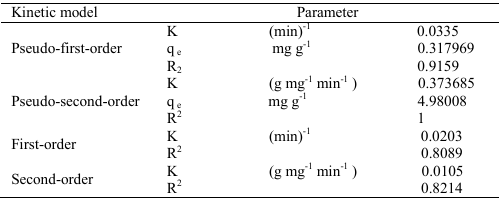
Table 1:Kinetic parameters for Hg(II) sorption onto nanocomposite Table 1. Kinetic parameters for Hg(II) sorption onto nanocomposite Kinetic model